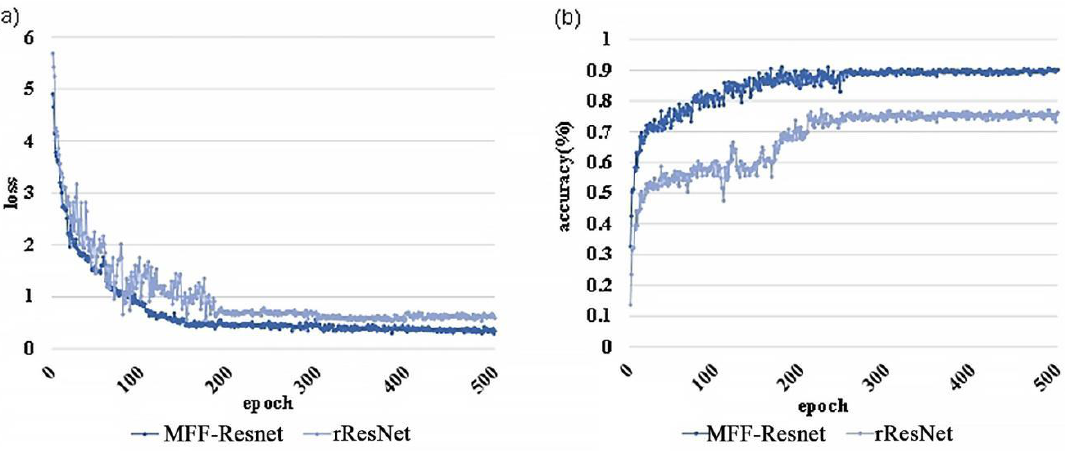
Figure 11. Wave plot and log-scaled Mel-spectrogram of eight different sound source scenes. It can be clearly seen that there are obvious differences between the sound fragments of different types of sound sources.